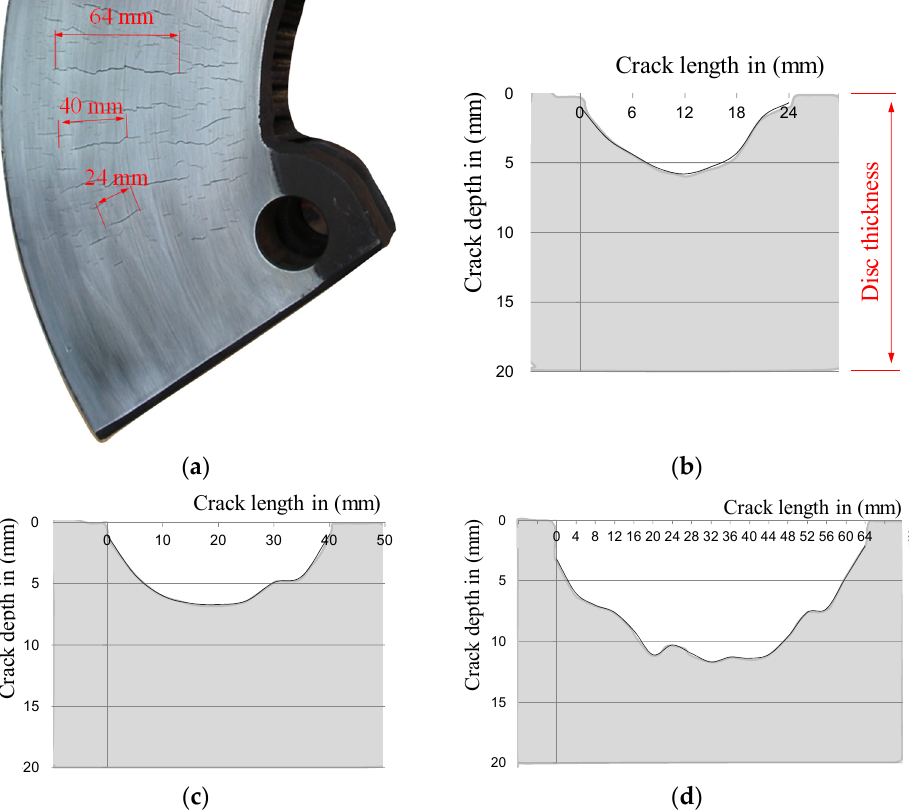
Figure 11. Surface cracks (microcracks) on the ring of the railway brake disc: ( a ) microcracks mesh on the BK141 segment of the disc, ( b ) disc cross-section with a 24 mm long crack, ( c ) disc cross-section with a 40 mm long crack, and ( d ) disc cross-section and a crack with a length of 64 mm. For further research, of which the main goal was to determine the depth of surface Analyses of all the cases of the tested brake discs allowed to determine that the largest group of microcracks were cracks with a length of 30 to 40 mm. Only in a few cases were cracks longer than 55 mm observed. Moreover, it was found that in each case of the tested brake discs, the microcrack l p /g p coefficient increased logarithmically with the increase 0.9 for this function in relation to other approximating functions. It should be noted that